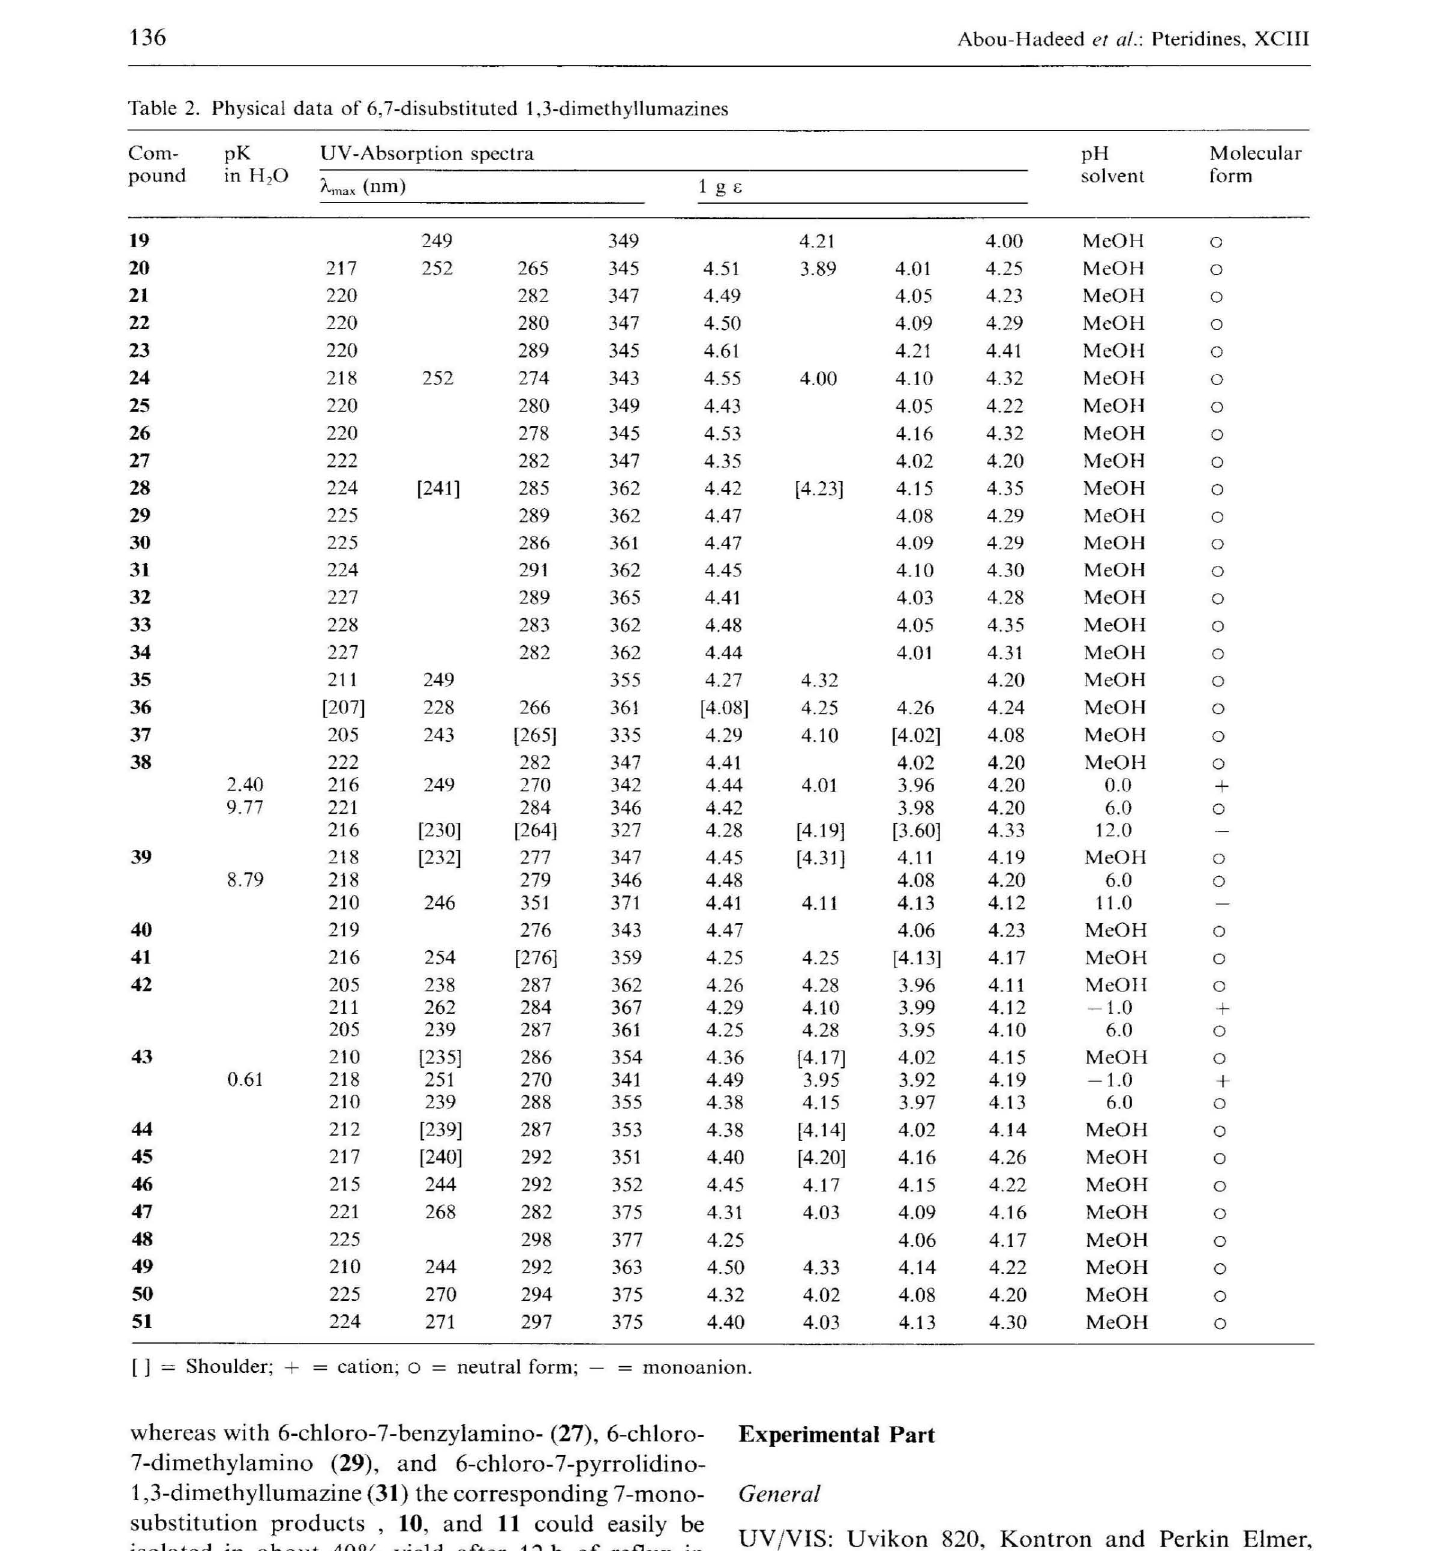
Table 2. Physical data of 6,7-disubstituted